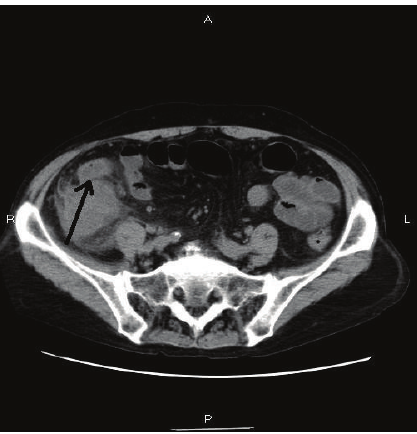
Figure 1: Abdominal CT. The appendix shows a mass measuring 5 × 4 × 4cm. The appendix cannot be identified (arrow).